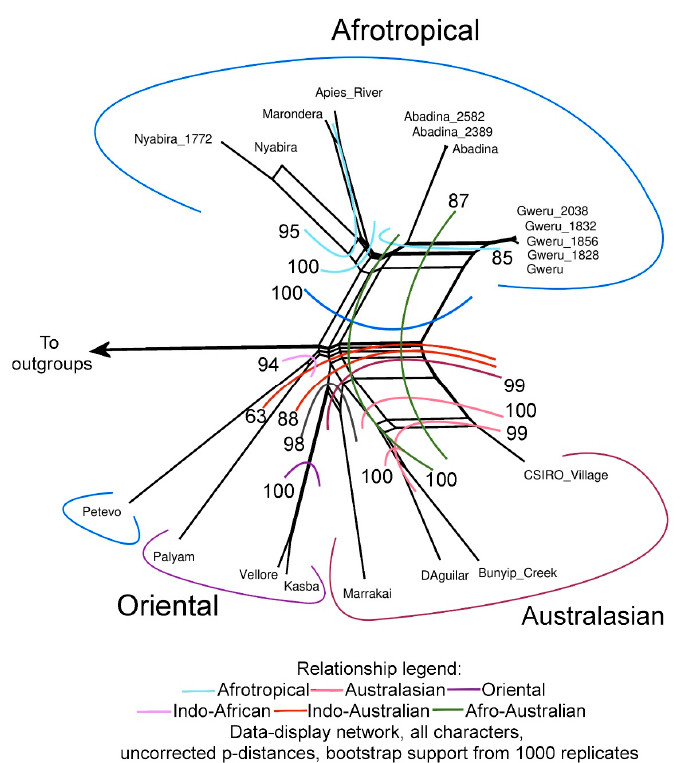
Figure1. Data-displaynetwork forallthe serotypesof thePalyamserogroupusedin thisstudy. Di ff erent Figure 1. Data-display network for all the serotypes of the Palyam serogroup used in this study. coloured lines present bootstrap support for di ff erent intra- and inter-geographical relationships among Different coloured lines present bootstrap support for different intra- and inter-geographical serogroups. Arrow to outgroups: AHSV, BTV, EEV and EHDV. Viruses 2019 , 11 , x FOR PEER REVIEW relationships among serogroups. Arrow to outgroups: AHSV, BTV, EEV and EHDV.